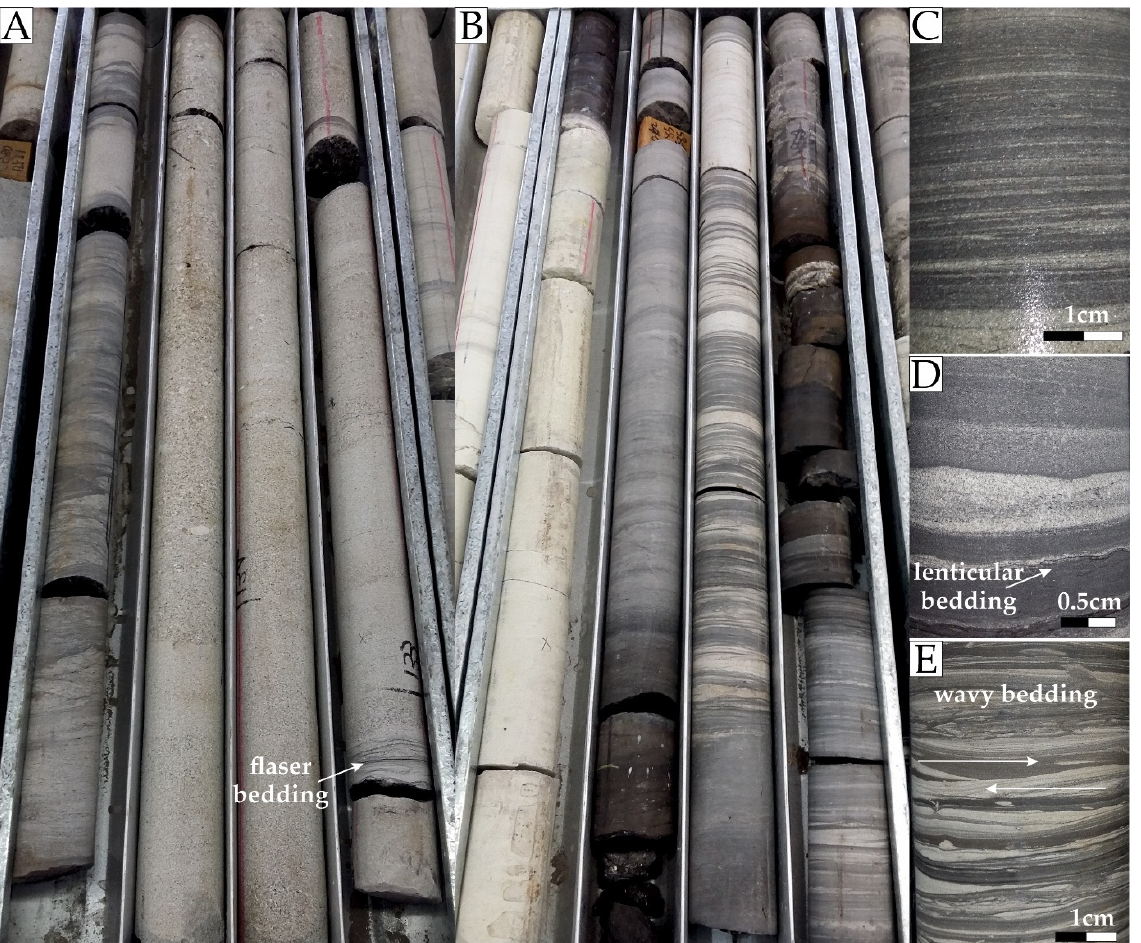
Figure 6. Core photographs illustrating sedimentological characteristics of the FA4 (overbanks). ( A ) Alternations of structureless, parallel-laminated and heterolithic bedding with structureless and/or parallel-laminated mudstone. They are underlain by structureless sandstone that belong to the lower delta-plain deposits. Note the presence of flaser bedding in the delta-plain deposits that document the presence of tidal currents during sedimentation. ( B ) Repetitions of heterolithic bedding and structureless sandstone with structureless, parallel-laminated mudstone and ripple cross-laminated mudstone. The overbank deposits evolve upward into coal-prone floodplain deposits (FA5). ( C ) Rhythmic repetitions of ripple cross-laminated sandstone with parallel laminated mudstone. ( D , E ) Heterolithic bedding illustrating repetitions of flaser, wavy and lenticular bedding. The opposite directed ripples within the heterolithic bedding represent the flow directions of the ebb and flood currents.